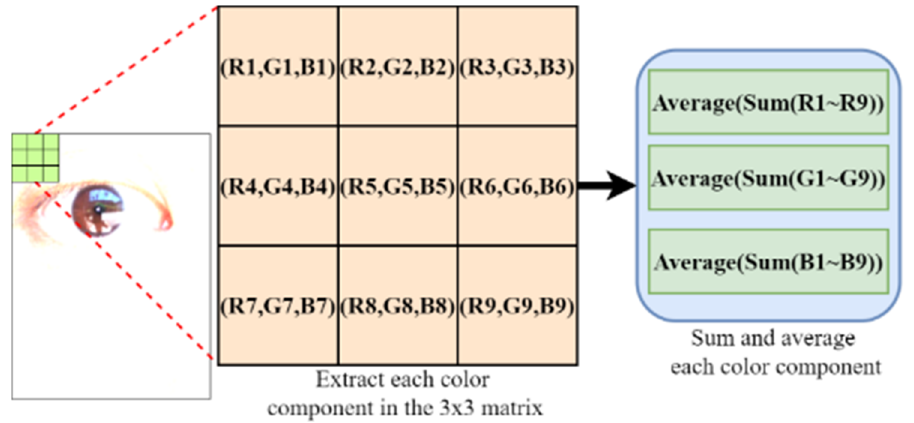
Figure 10. Average matrix for an image with enhanced exposure.